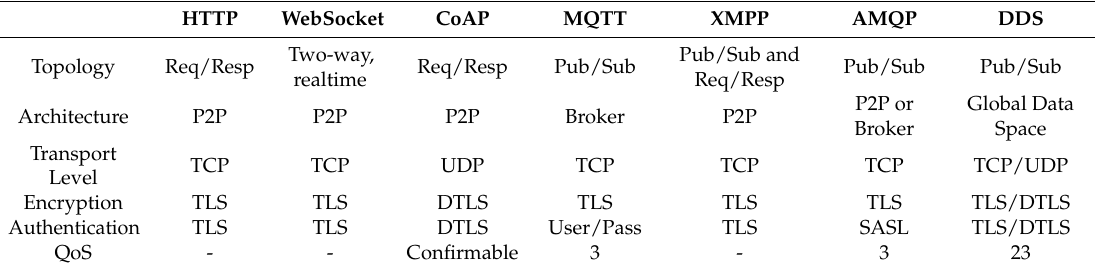
Table 1. WoT/IoT